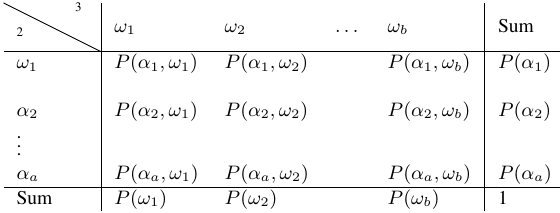
Table 2. Data used for validation and training in hectares (ha).